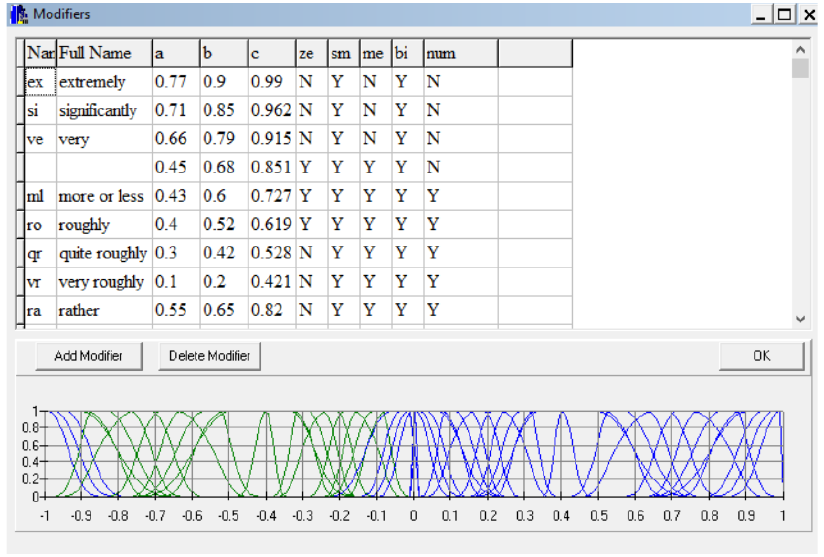
Figure 6. Modifiers and atomic expressions settings.